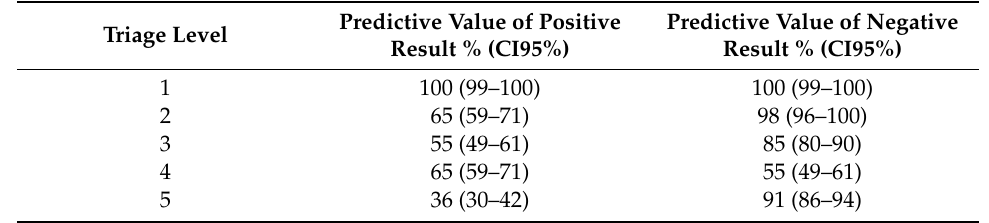
Table 3. Validity parameters of predictive criteria for each level of triage obtained with the ESI triage system in the Emergency Service Department of the General Hospital of La Palma between February 2016 and February